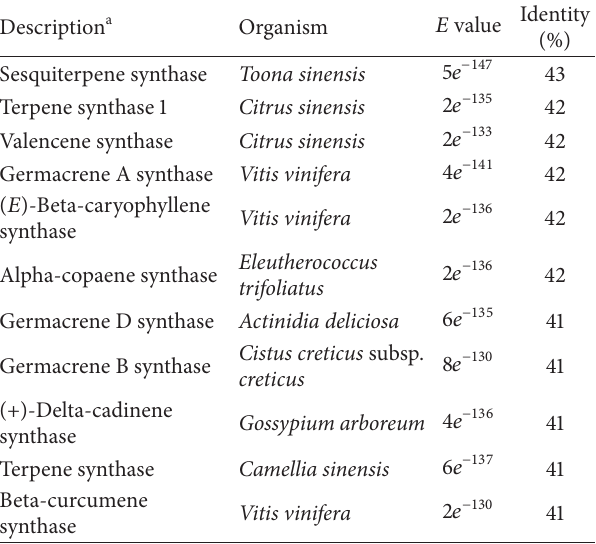
Table 1: BLASTX analysis. PmSTS was compared with the NCBI protein database for gene identification purposes.